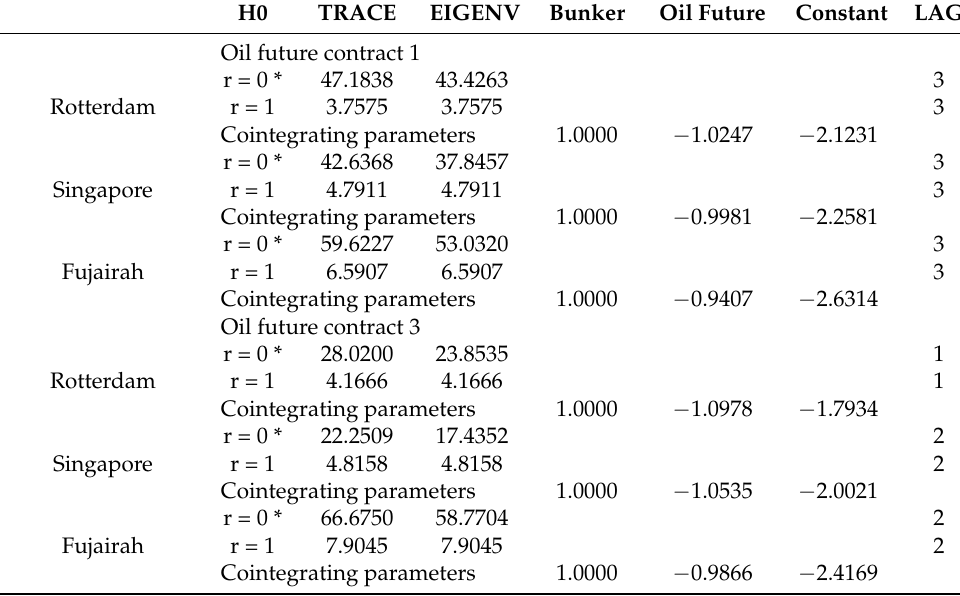
Table 3. The Johansen cointegration test